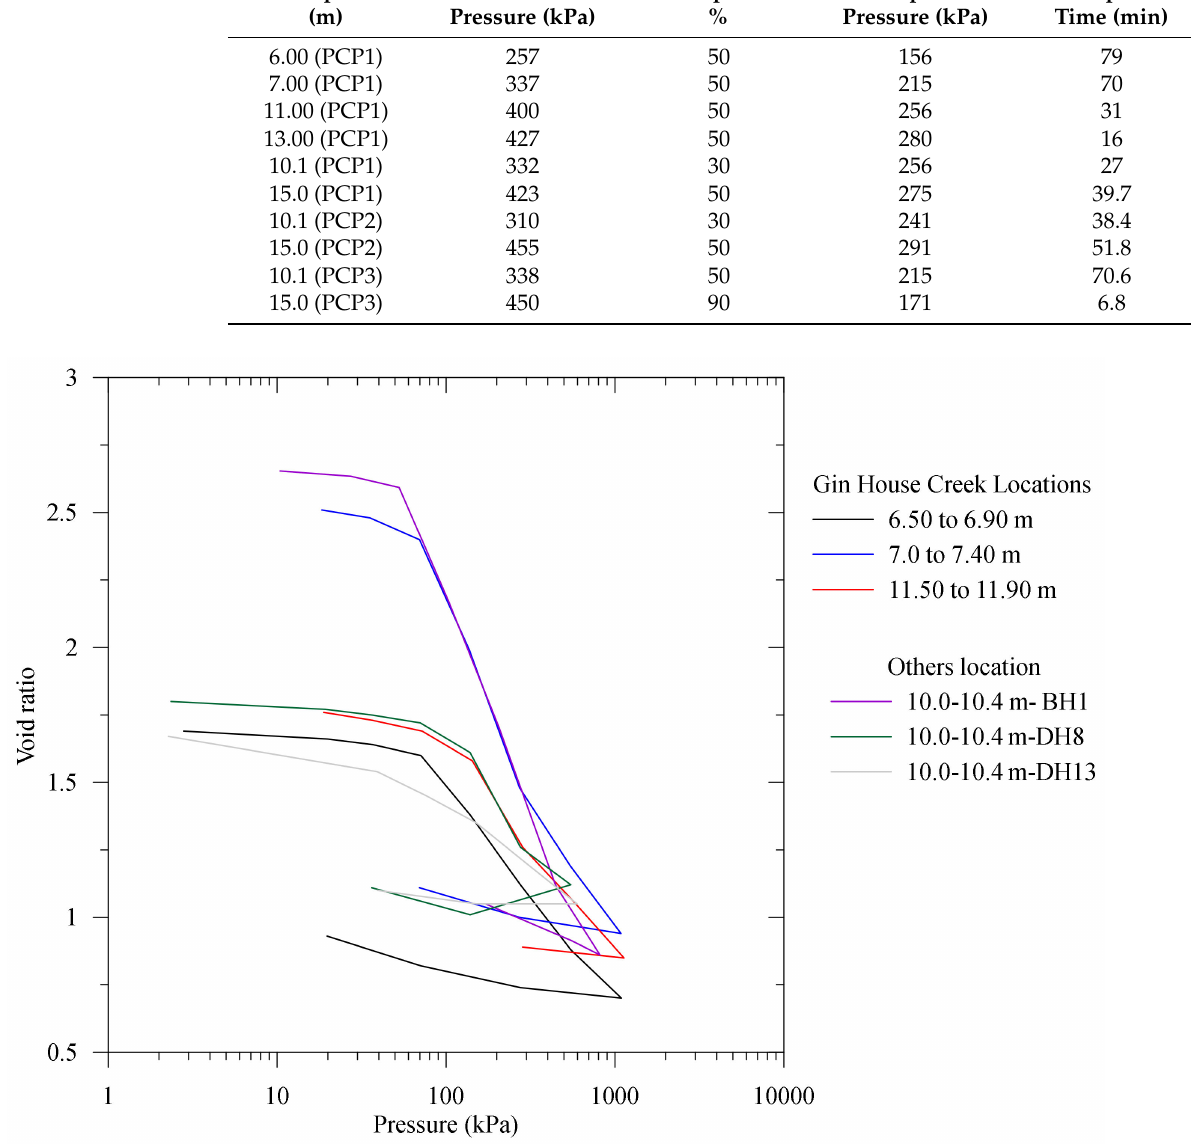
Figure 12. Consolidation test data of the embankment’s foundation